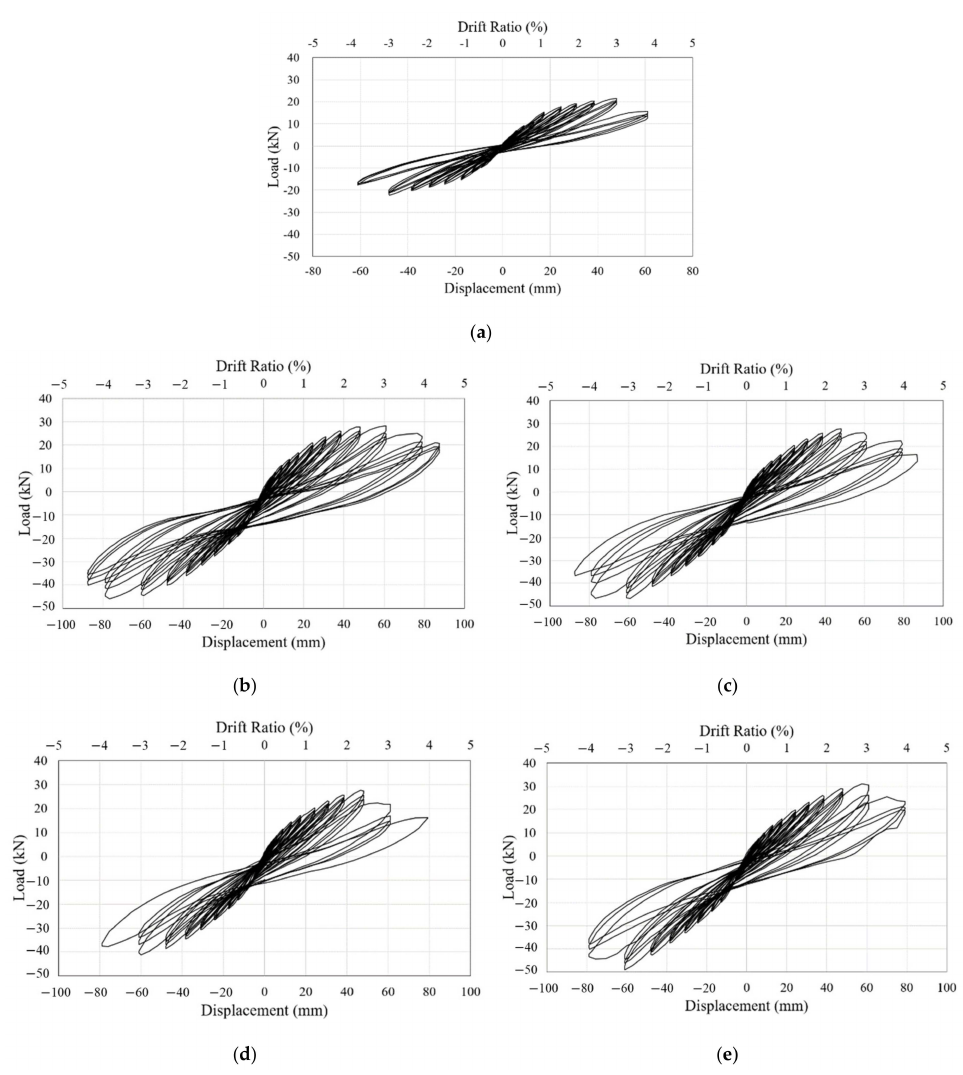
Figure 10. Load-displacement curves of the specimens: ( a ) NR; ( b ) R-375-1; ( c ) R-375-2; ( d ) R-575-1; ( e )